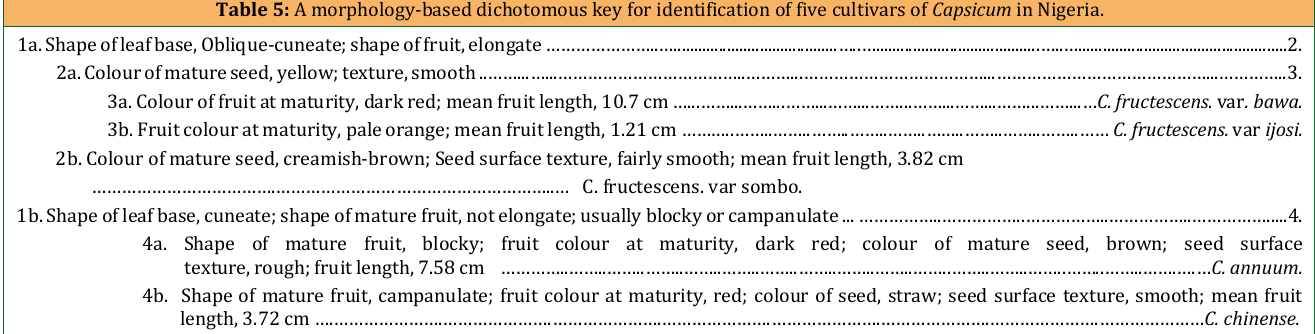
A morphology-based dichotomous key for identification of five cultivars of